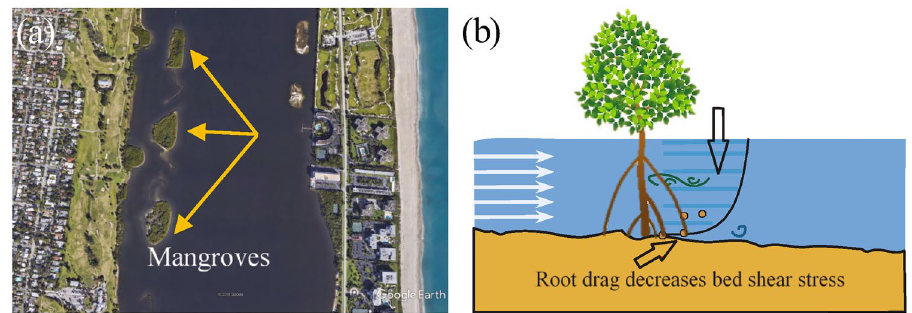
Figure 1. ( a ) Emergent patches of mangroves in Lake Worth Lagoon, Florida provide nursery habitat for species and animals by accumulating sediments and impede erosion due to the dense root structure. Google earth Pro 7.3.3.7786 (August 28, 2020). Lake Worth Lagoon, Florida. 26 2200 m https:// www. google. com/ earth/. ( b ) The elevated drag force dominated by dense roots creates a small eddy size and affects bed shear stress. The top arrow and the lines represent the vortex shedding and velocity profile, respectively, which enhances the sediment trap by modulating the near-bed flow